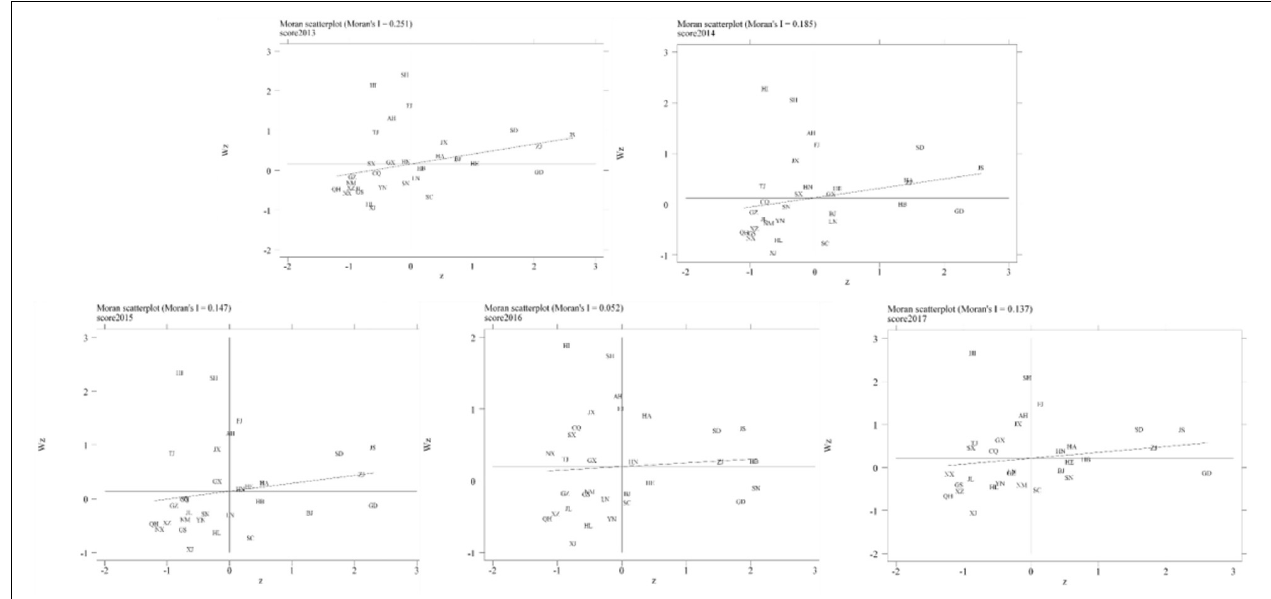
FIGURE 9 | Moran Scatter Plot of the resilience of China’s Sports Region Development from 2013 to